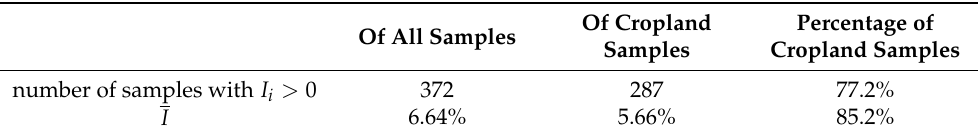
Table 8. Accuracy improvement by adding data acquisition time over total samples and cropland samples.